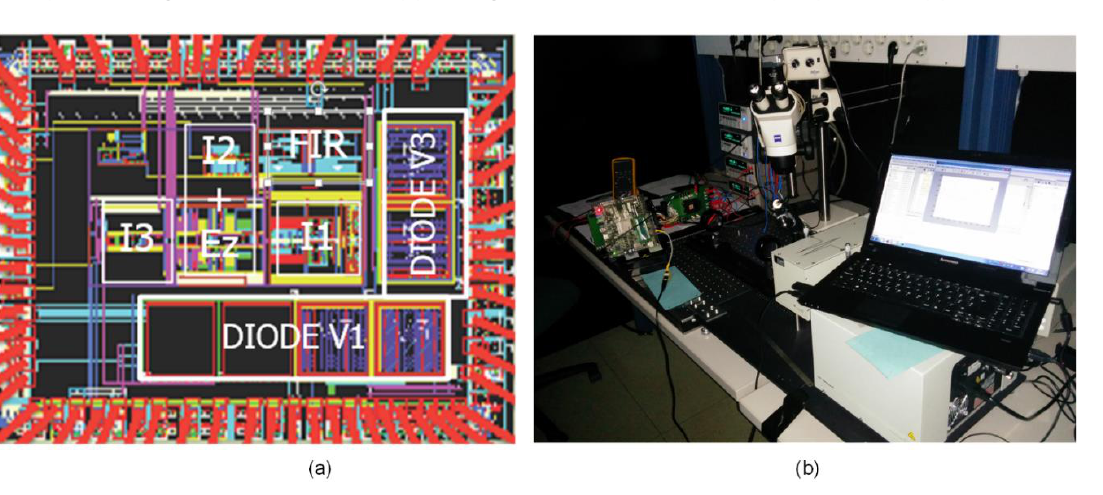
Figure 18. ( a ) Photo-micrograph of the chip including four photo-diodes input multiplexer and 3rd order modulator with FIR-DAC and compensation filter. DSP is implemented on the FPGA; ( b ) Optical measurement